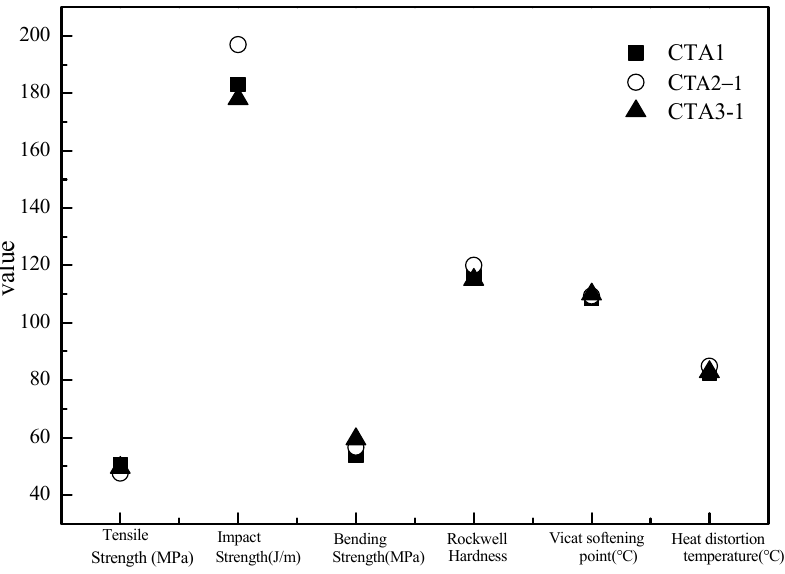
Figure 3. E ff ect of di ff erent chain transfer agents on properties of the resulting ABS resins.